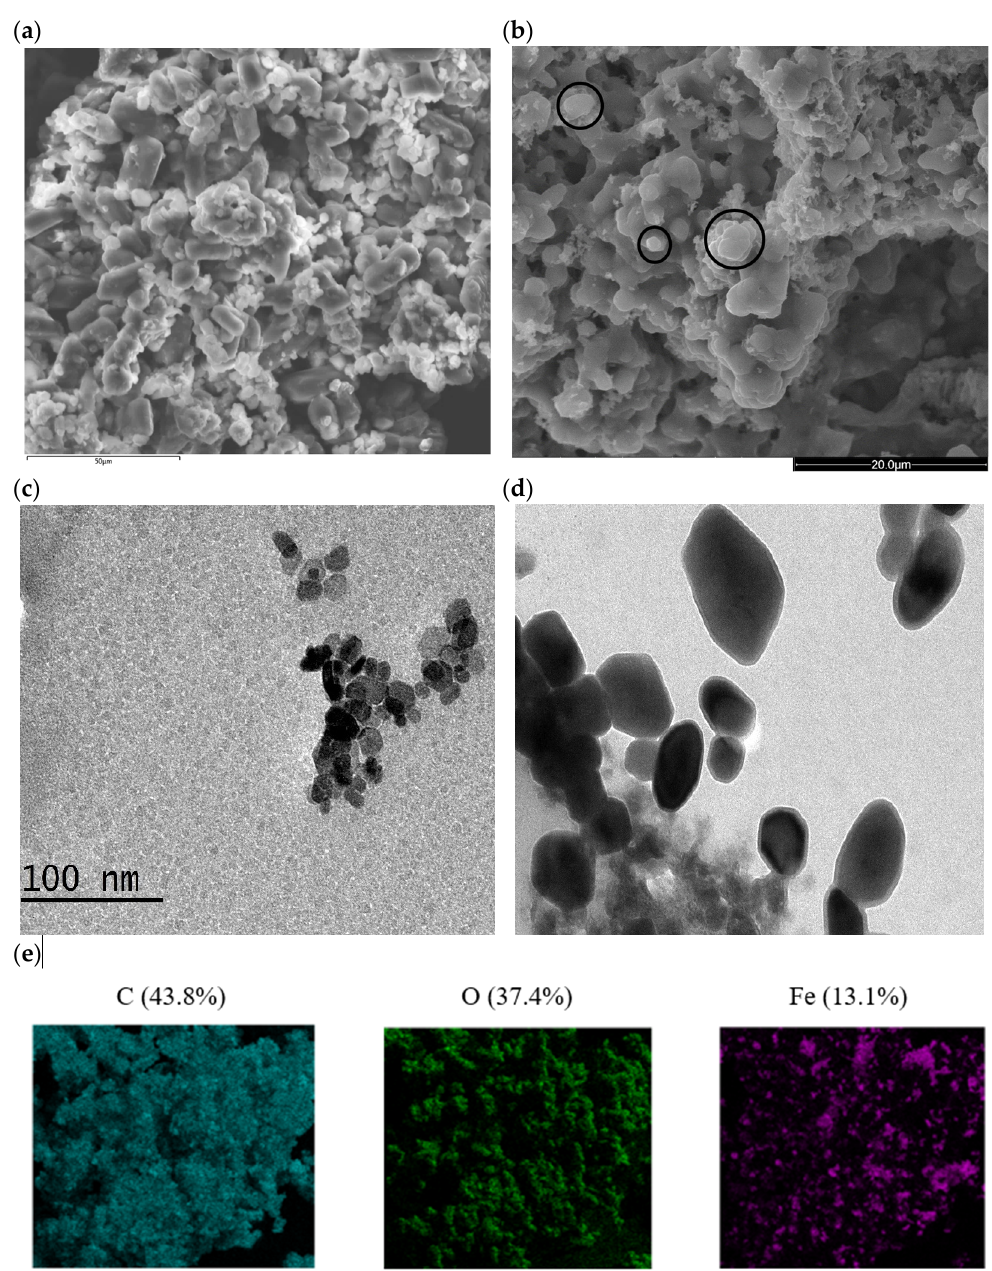
Figure 2. Characterisation of the synthesized catalyst: SEM images at ( a ) 50 µ m and ( b ) 20 µ m, with identification of hematite (indicated in empty circles); TEM images of ( c ) spheres of hematite and ( d ) non-uniform spheres of hematite; ( e ) mapping of the catalyst, including data of the main components determined by EDS analysis.